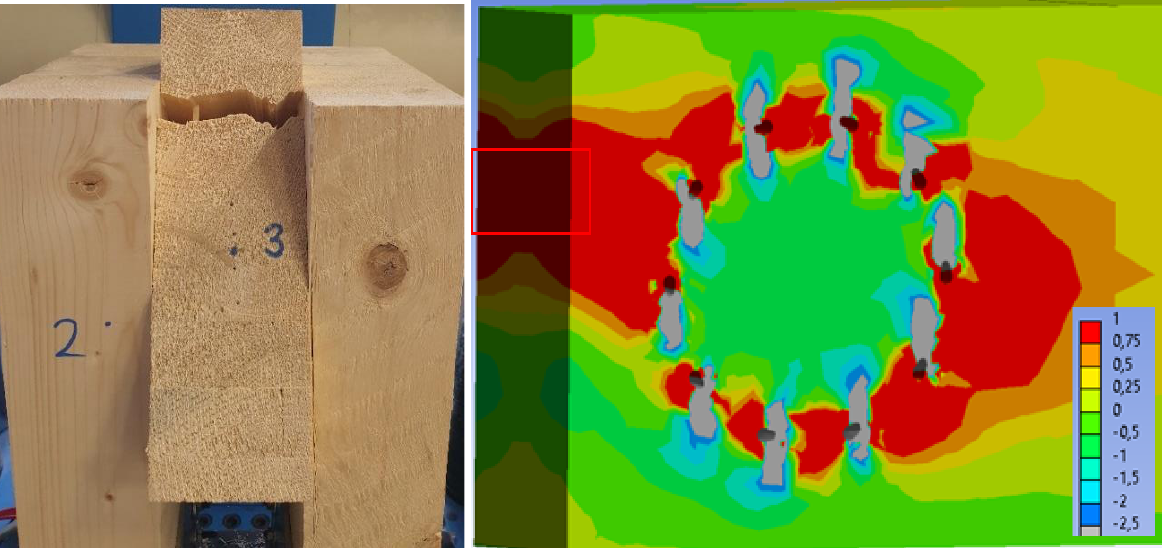
Figure 23. Experiment A: Collapse of the connection during experimental testing (on the ( left )), tensile stress perpendicular to the grain from the numerical model (MPa) (on the ( right )).